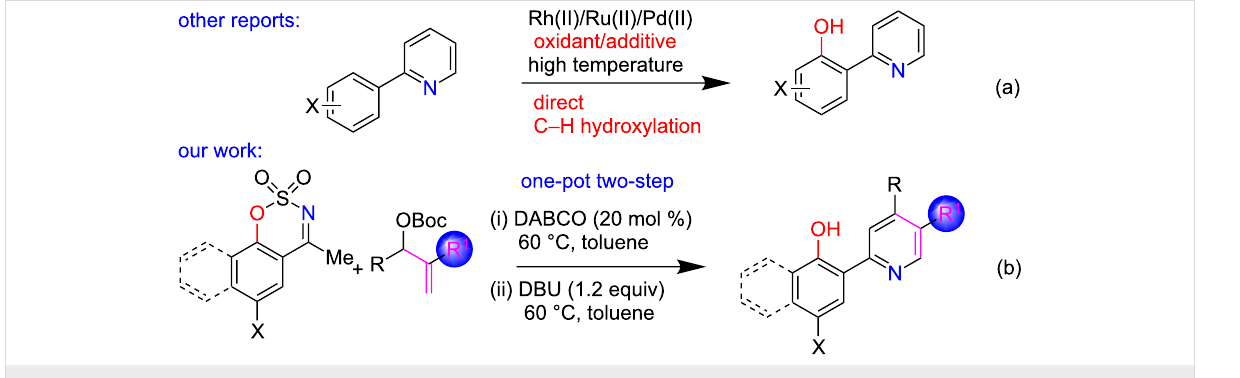
Scheme 1: One-pot access to